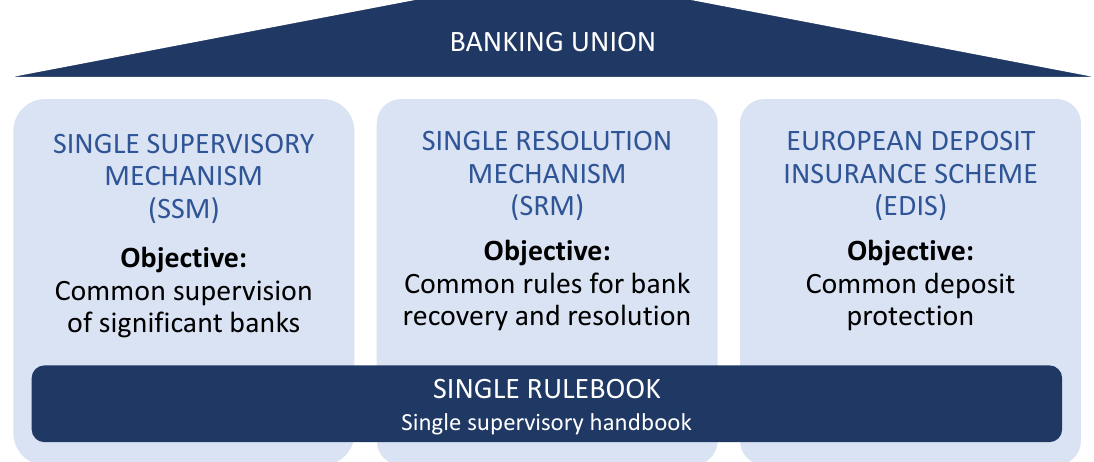
Figure 2. The structure of the European Banking